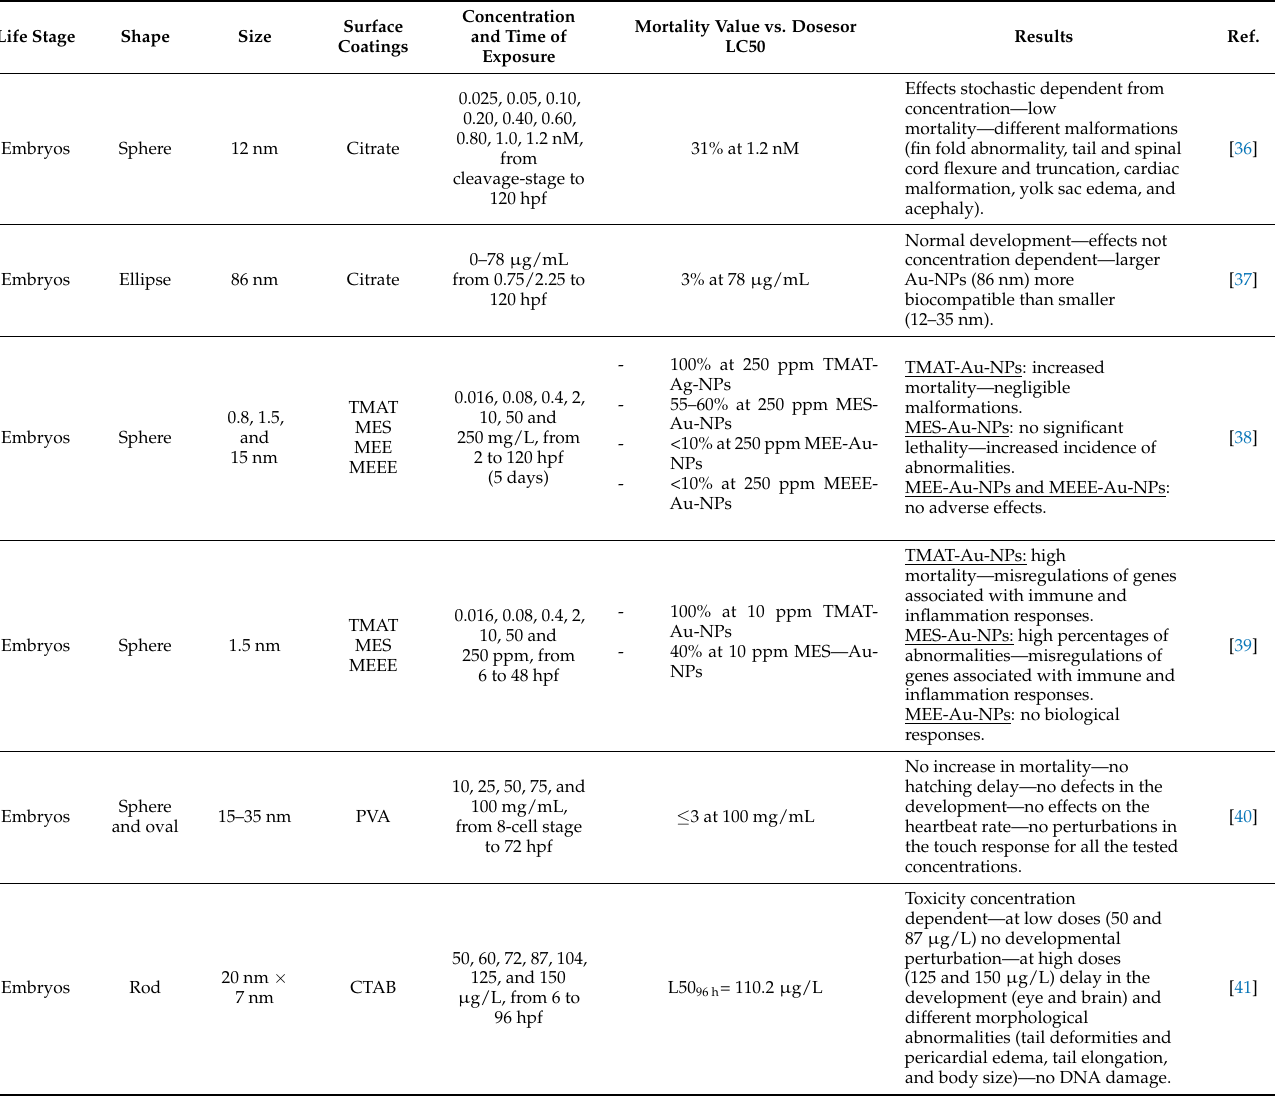
Table 1. Effects of gold nanoparticles with different sizes, shapes, and surface coatings in zebrafish. Concentration Surface Mortality Value vs. Dosesor and Time of Coatings LC50 Results Exposure